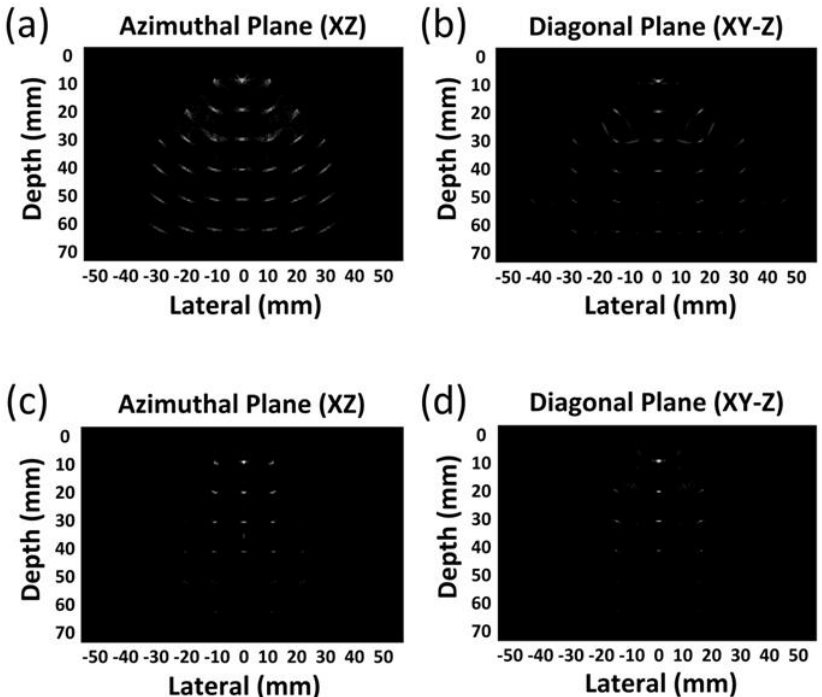
Figure 6. B-scan images acquired from the unfocused FT-XR with DTxF using 31 × 31 plane waves in the ( a ) azimuthal and the ( b ) diagonal planes, and with DTxF using 11 plane waves in the ( c ) azimuthal and the ( d ) diagonal planes.